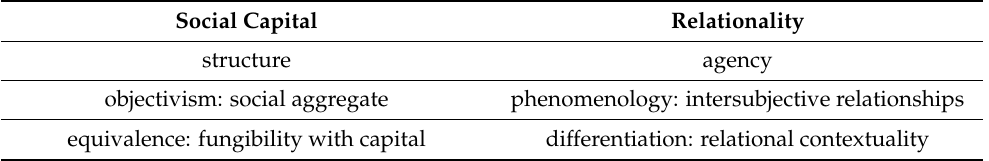
Table 1. Mapping Concepts: Social Capital vs. Relationality. Social